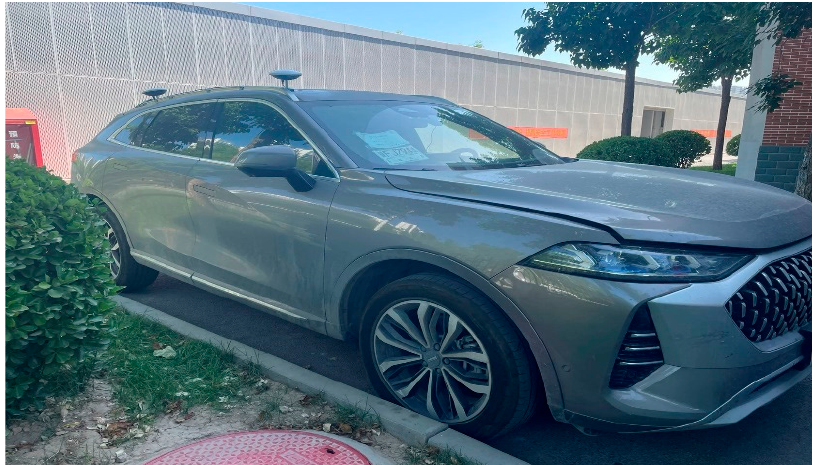
Figure 11. Autonomous vehicle test platform.